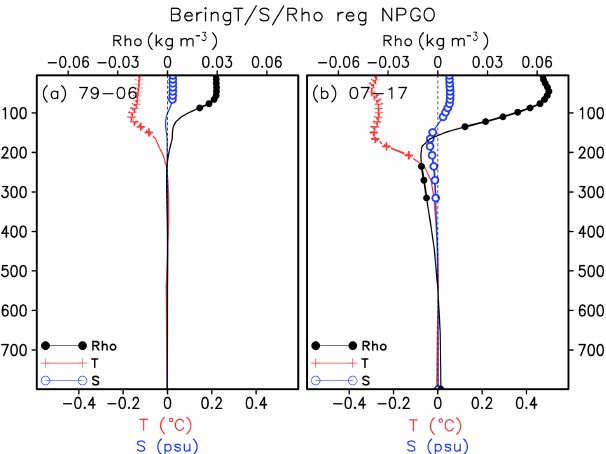
Figure 13. Regression of spring (March–May mean) Bering deep basin temperature, salinity and density on the NPGO index during the 1979–2006 period (a) and the 2007–2017 period (b) for each depth layer. The black dots, red crosses and blue circles denote the regression coefficients that are significant at the 85% significant t test for density, temperature and salinity,